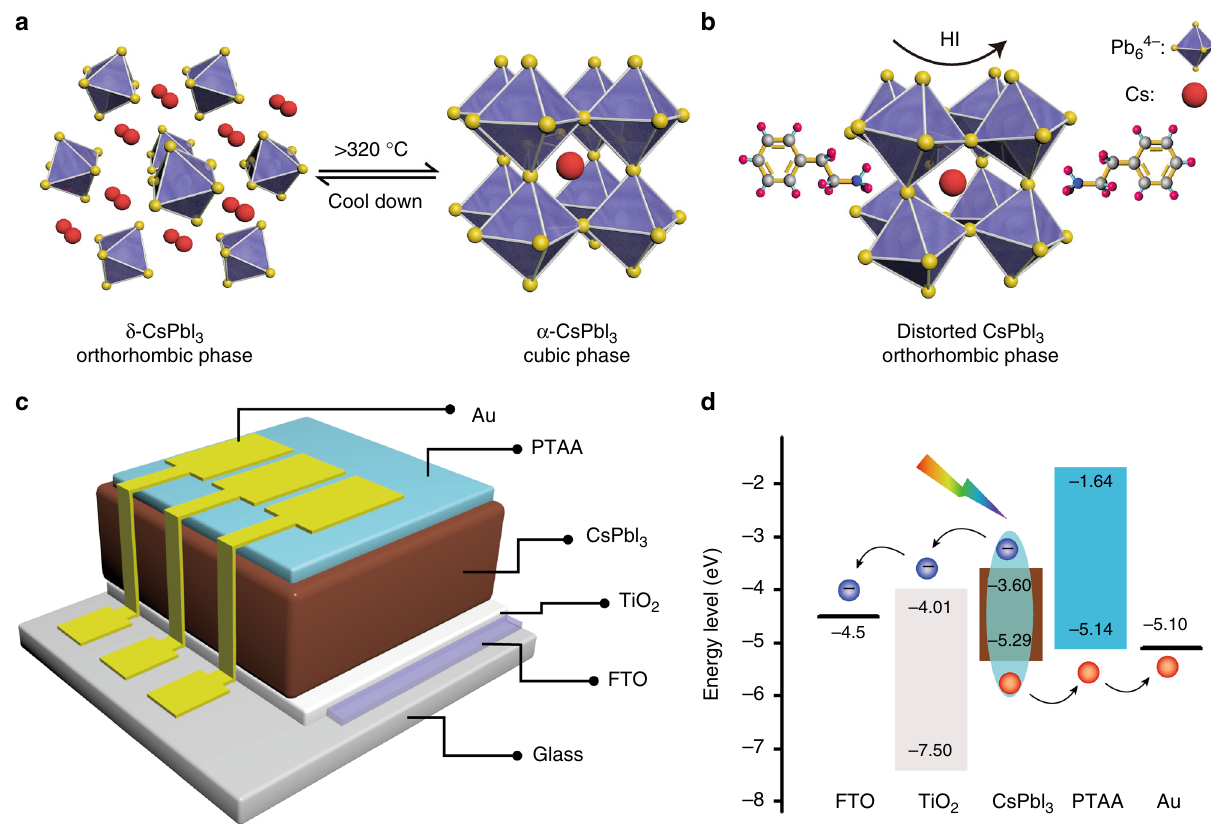
Fig. 1 Structure and energy level: a Schematic of common CsPbI 3 phases; b HI-induced and PEAI-stabilized distorted black CsPbI 3 orthorhombic phase; c Schematic device structure; d energy